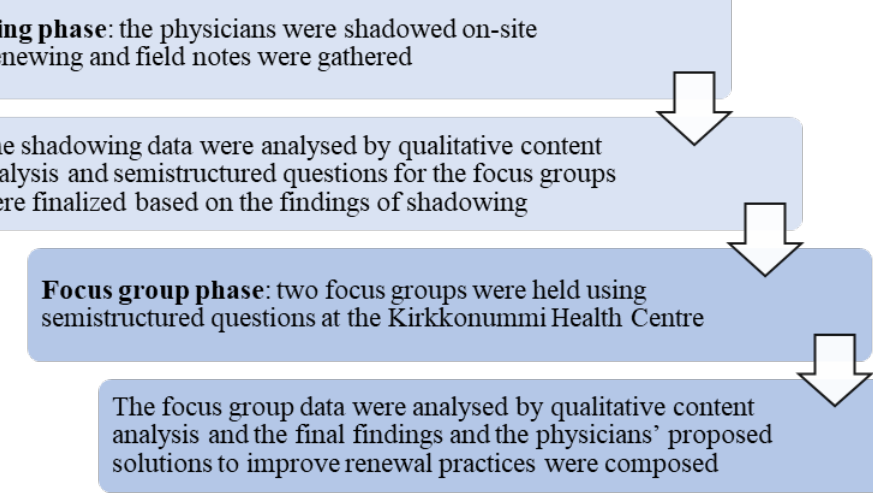
Figure 1. The two-phase study design.